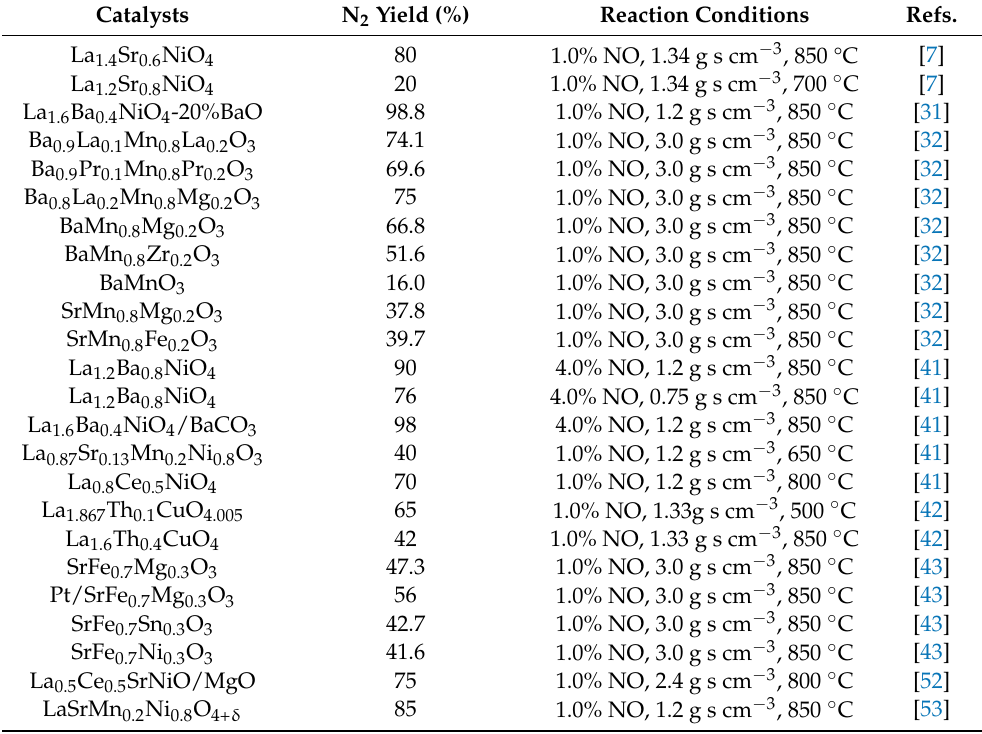
Table 1. A summary of the reaction conditions and maximum nitrogen yield of major perovskite